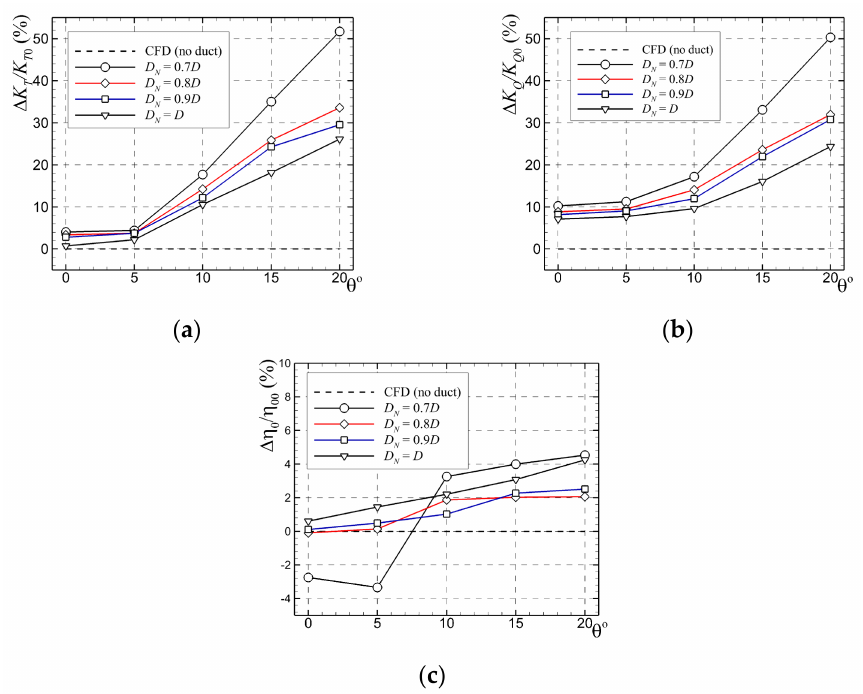
Figure 10. Ratio of force coefficients for different nozzles reported to those of the single propeller. ( a ) ratio of thrust coefficient, ( b ) ratio of torque coefficient, ( c ) ratio of open water